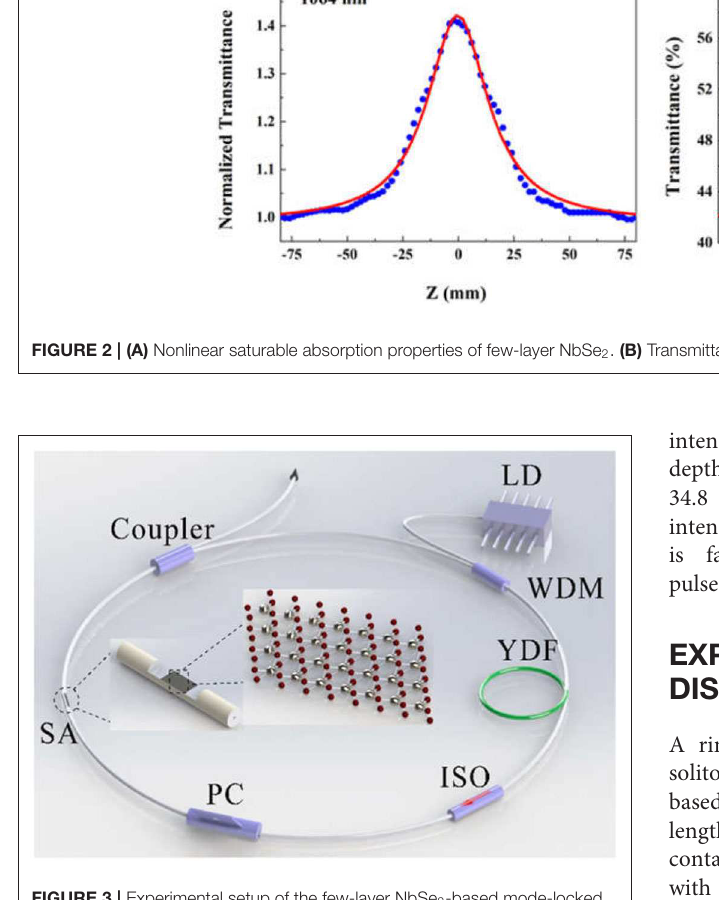
NbSe 2 is about 1.1 nm [44], showing the few-layer nature of the NbSe 2